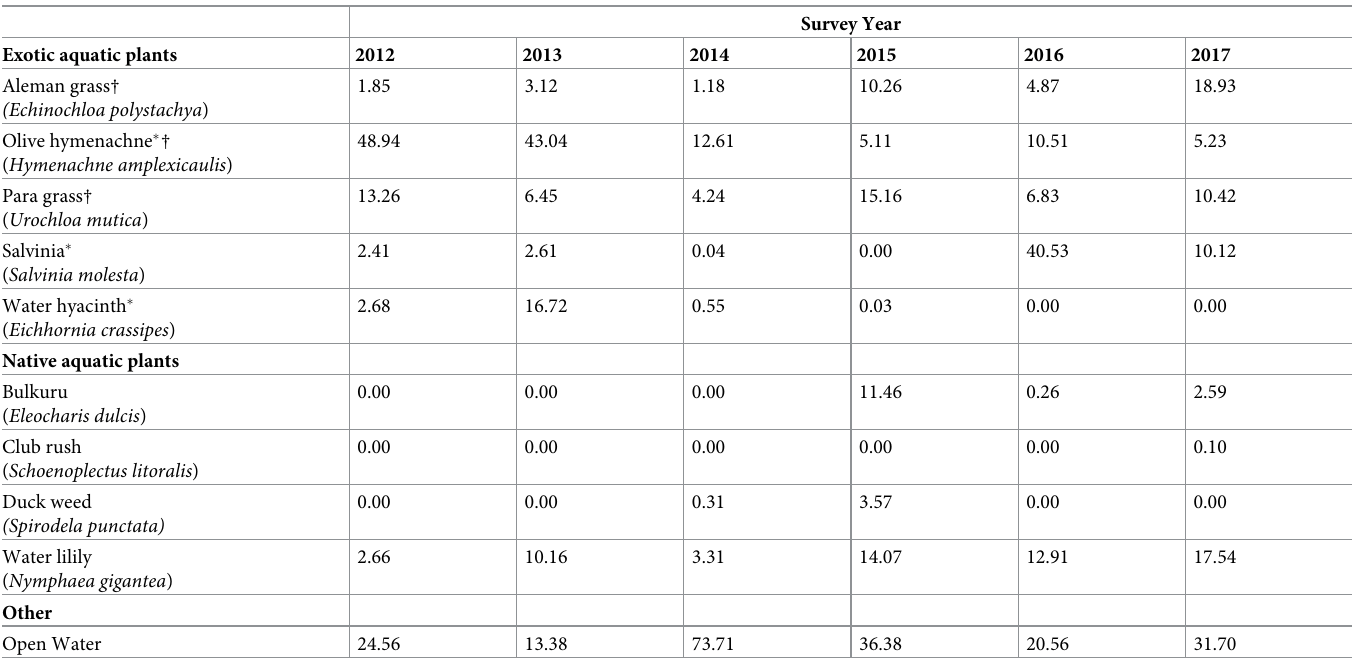
Table 2. Area inhabited by vegetation groups